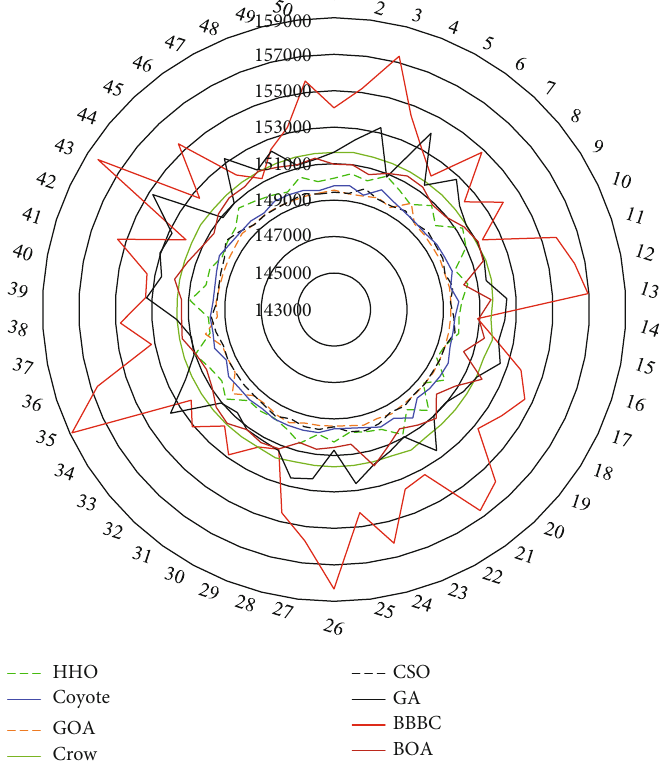
Figure 9: The ASC vs. run number for metaheuristic